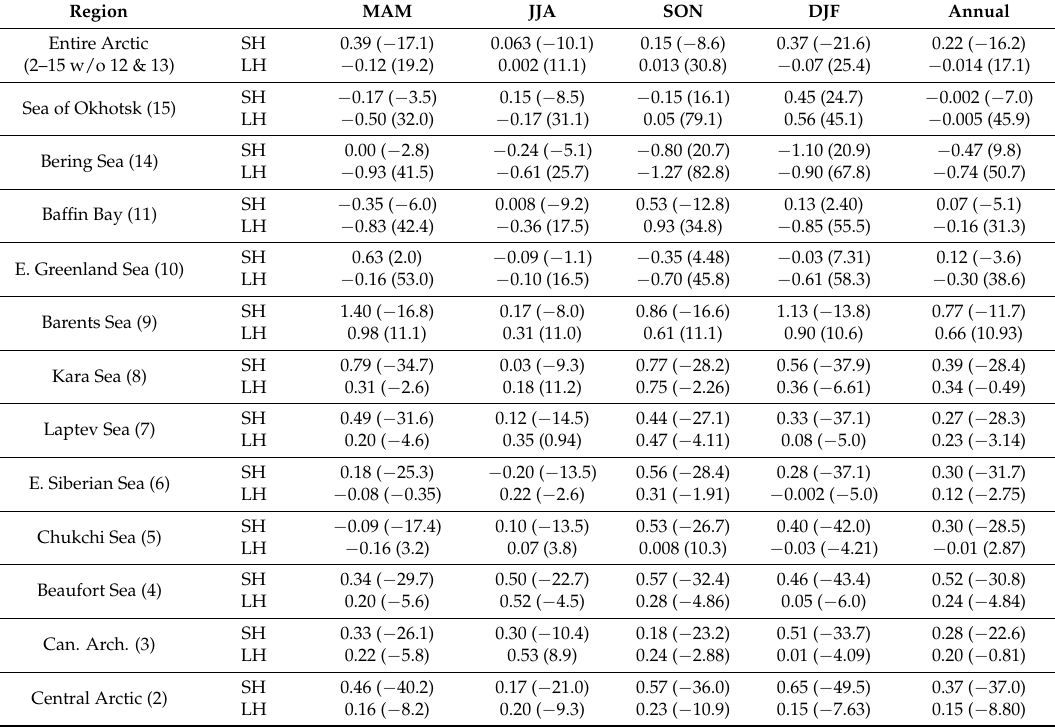
Table 3. Summary of SH and LH Trends (Units: W m − 2 yr − 1 ) and 2003–2015 average values in parentheses (Units: W m − 2 ). Each region is numbered corresponding to Figure